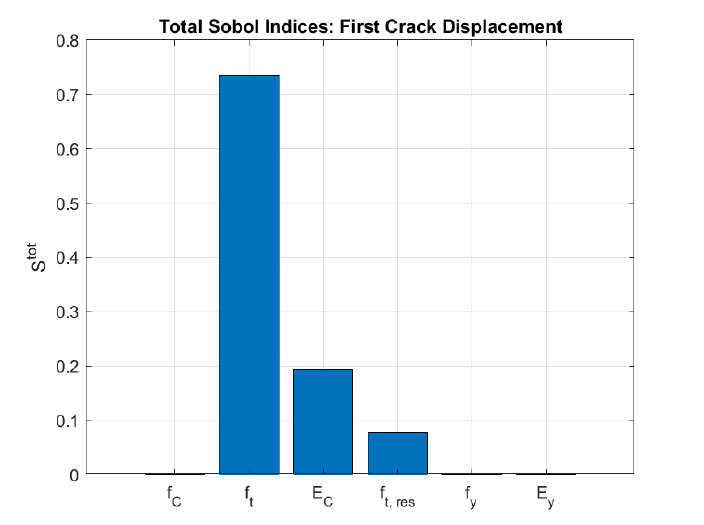
Figure 15. Total Sobol’ indices for first-crack displacement. Figures 16 and 17 present total Sobol’ indices for yield force and yield displacement.